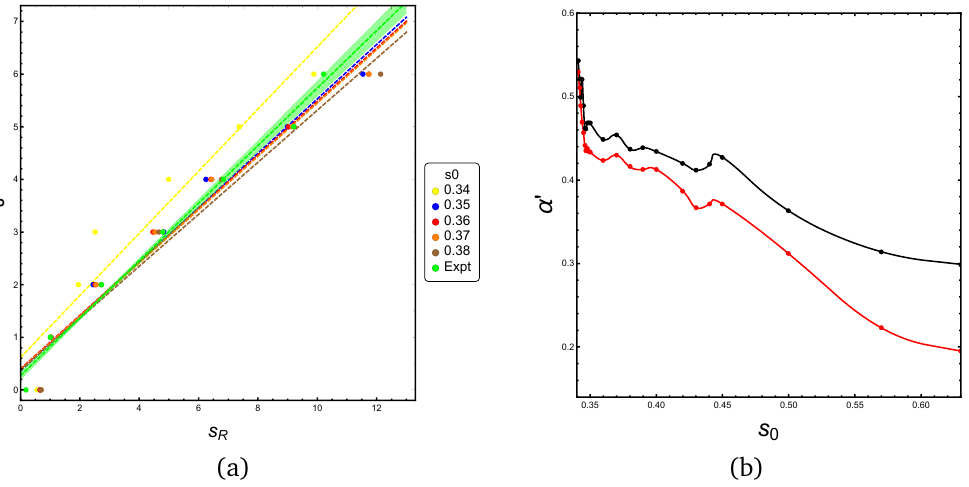
Figure 2: (a) Variation of best fit line with s 0 on the upper boundary. For s 0 = 0.35 the best fit line including (cid:96) = 0 to (cid:96) = 6 is given by J = 0.38 + 0.51 s R while the experimental one is J = 0.27 + 0.54 s R (Experimental masses of mesons taken from [ 29 ] ).(b) Variation of the slope α ′ of even(black) and odd(red) spins with s upper boundary in the neighbourhood of A . Except near s 0 ≈ 0.35 the even / odd spins